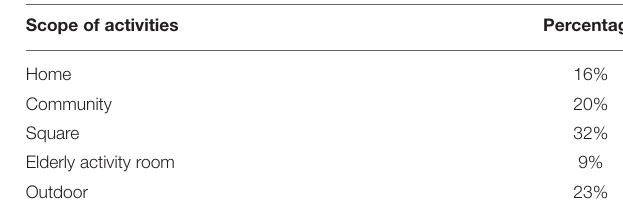
TABLE 2 | Analysis of scope of